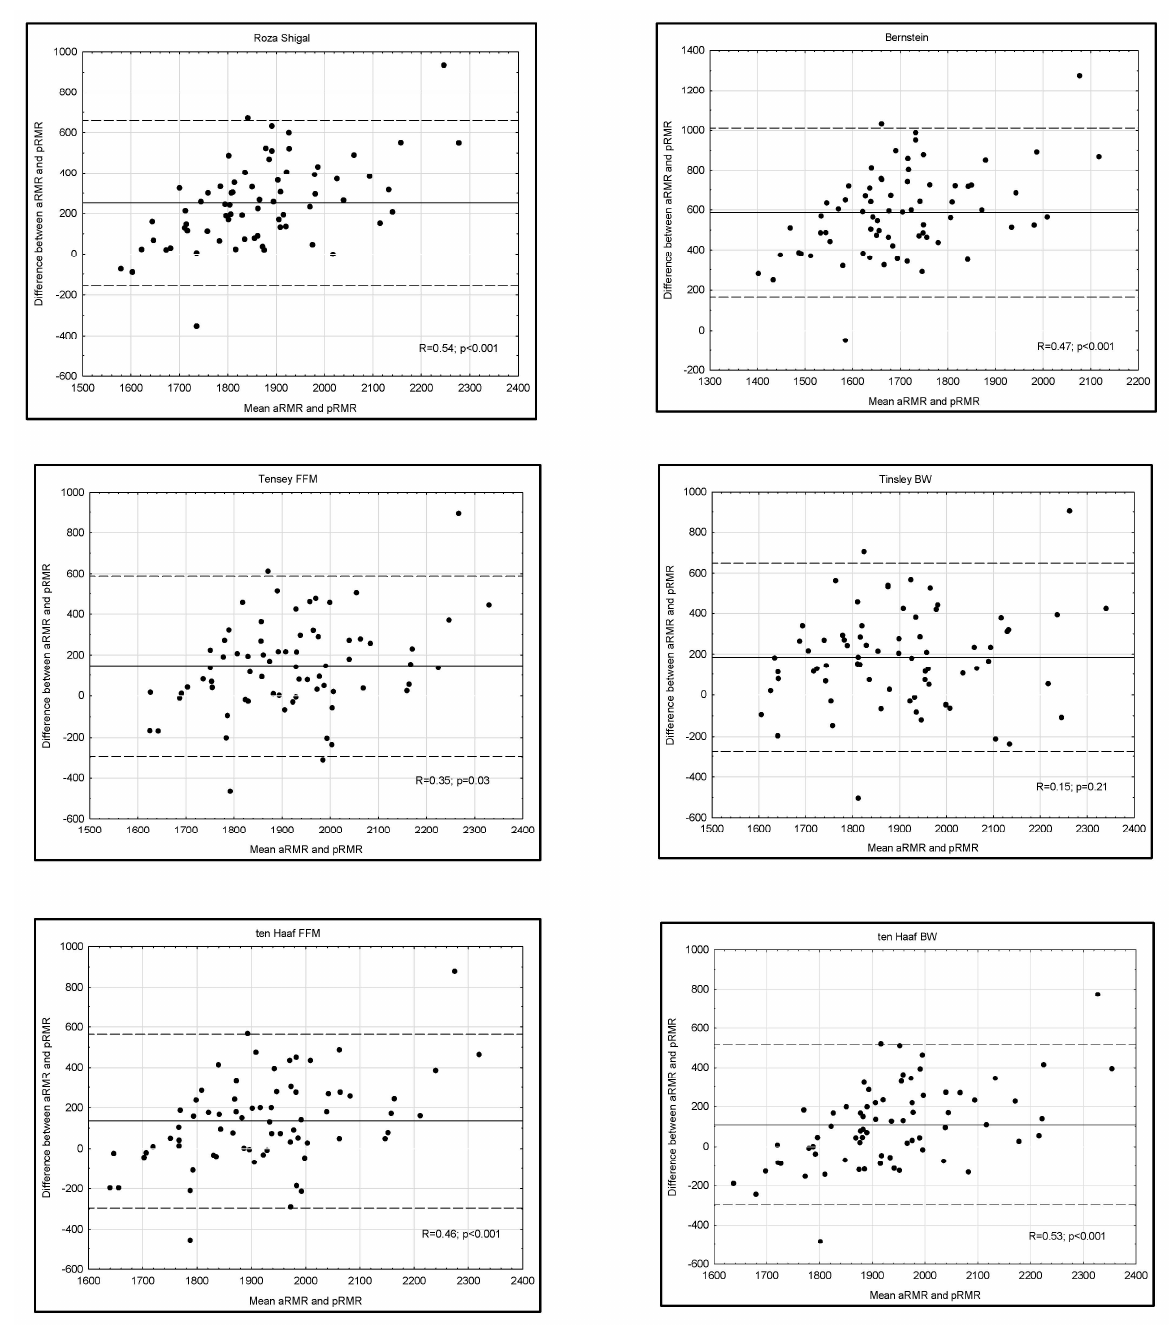
Figure 2. Bland–Altman plots for IC-RMR and predictive RMR equations for the subjects. The solid line represents the mean difference (BIAS) between RMR measured by Fitmate WM and predicted RMR. The upper and lower dashed lines represent the 95% limits of agreement. Here, ( A ) represents Bland–Altman plots of female athletes and ( B ) represents Bland–Altman plots of male athletes.